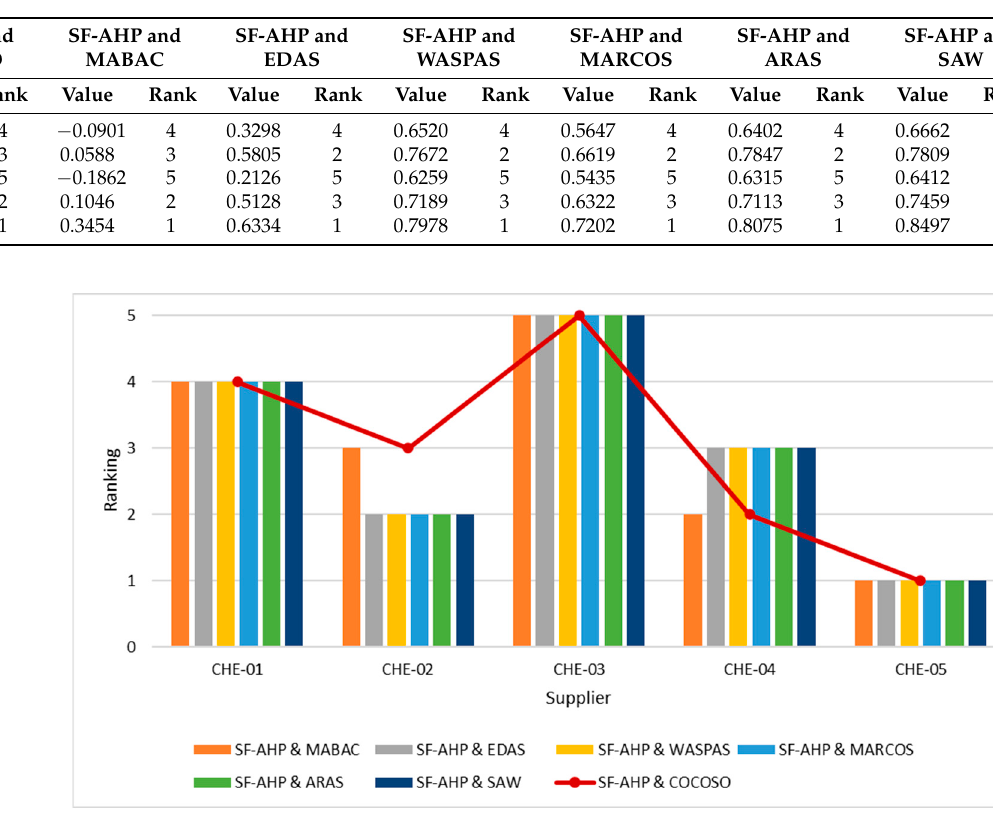
Figure 6. Comparison of the CoCoSo method with other MCDM methods.